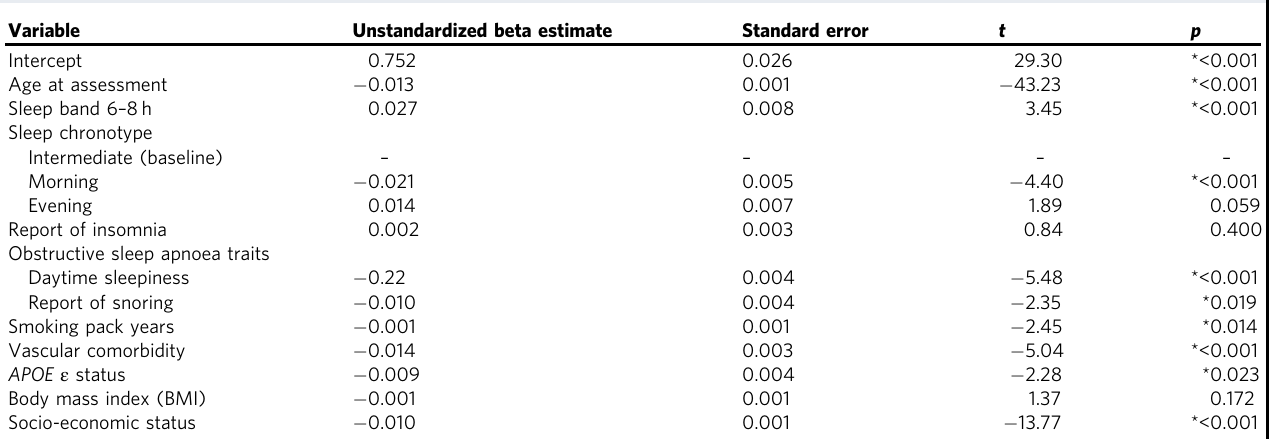
Table 1 Sleep, genetic, socioeconomic and cardiovascular predictors of executive